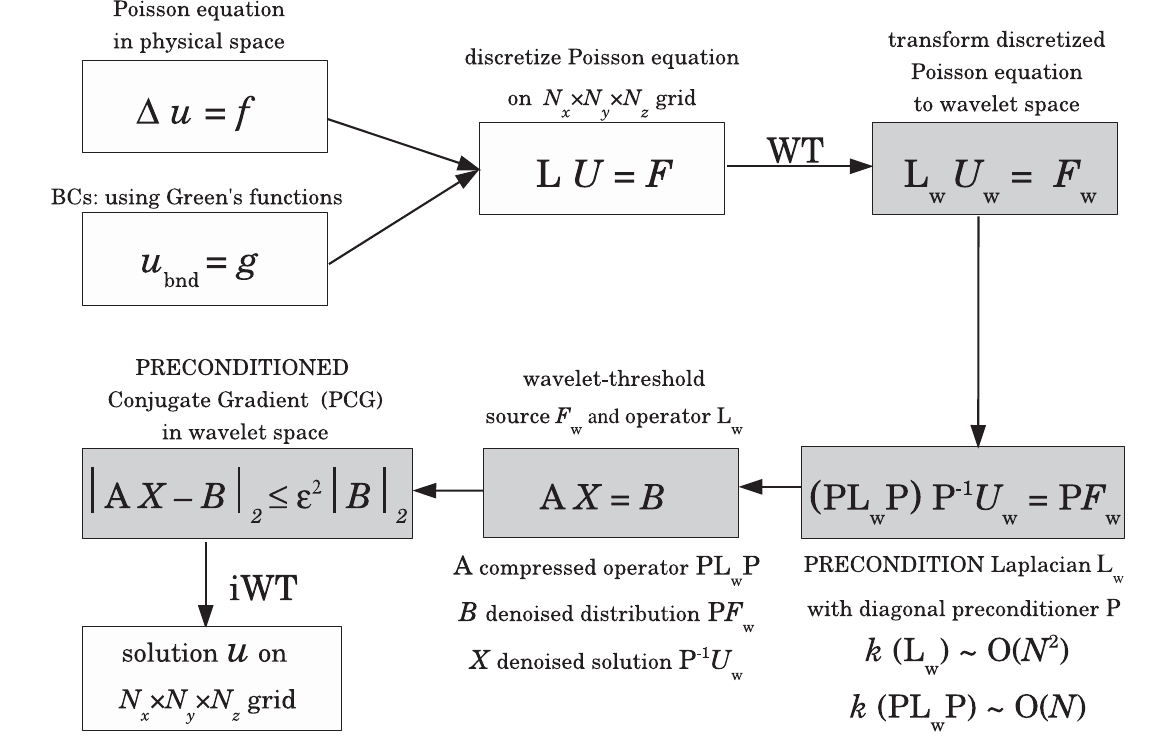
FIG. 1. Flow chart outlining the wavelet-based Poisson equation solver. The physical space is shown in white boxes, and the wavelet space in gray. First, the continuous Poisson equation with Dirichlet BCs is discretized on the finite grid in physical space, thus reducing it to a discrete linear algebra problem. Next, the problem is transformed to wavelet space using discrete wavelet transforms (WT), where the efficient, diagonal preconditioner (P) was applied to the wavelet-transformed Laplacian operator L space, the wavelet-thresholding is applied to the source and the preconditioned Laplacian operator. The resulting linear algebra problem is then solved in wavelet space using a standard preconditioned conjugate gradient (PCG) method and a ‘‘smart guess’’ provided by the solution to the Poisson equation at the previous step in the PIC simulation (see Sec. II B). Finally, the solution on the grid in wavelet space is transformed using inverse wavelet transform (iWT) to yield the solution on the grid in physical